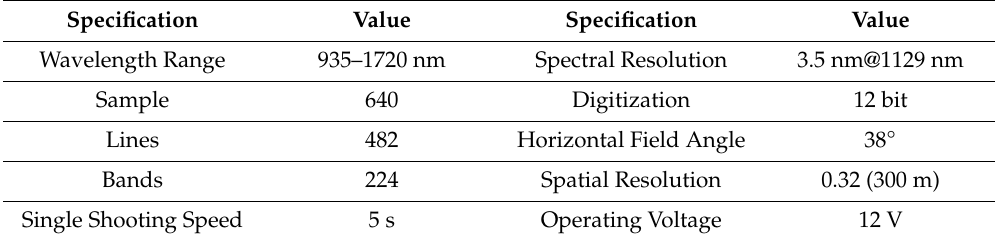
Table 4. Main parameters of the SPECIM_FX17E snapshot hyperspectral